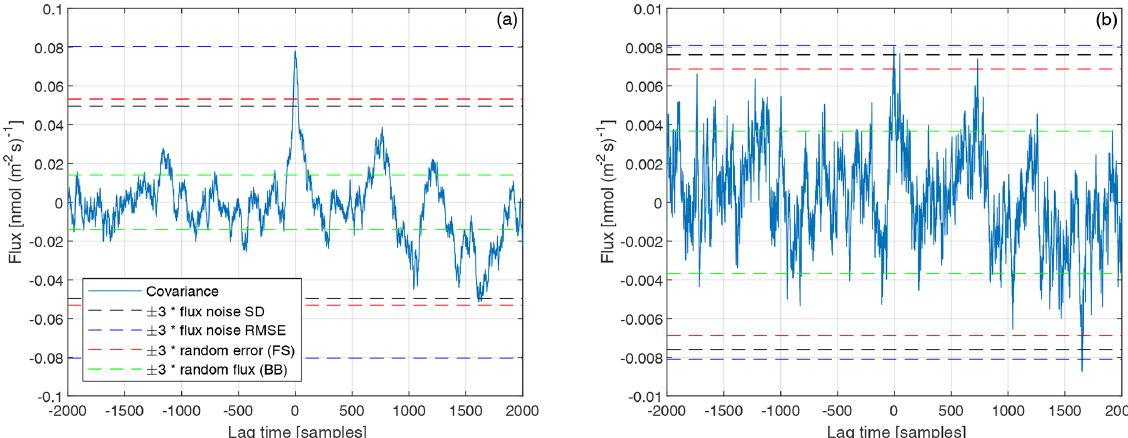
Figure 6. Covariance function and limit of detection (LOD) for toluene (a) and its 13 C isotope (b) estimated using different